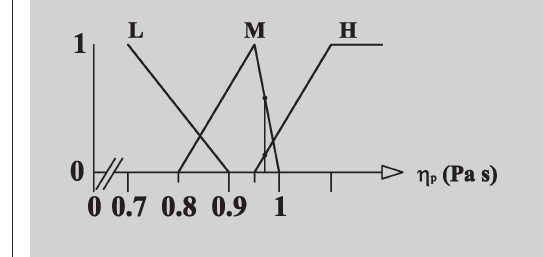
Figure 1: Example of fuzzification of the viscosity variable and classification of the datum < 0.97 Pa·s > as belonging, to a different extent, to two neighbouring fuzzy sets (M and H). M and H are next fuzzy sets but not necessari- ly are they also complemen- tary, so m (M(x)) + m (H(x)) could be π 1.